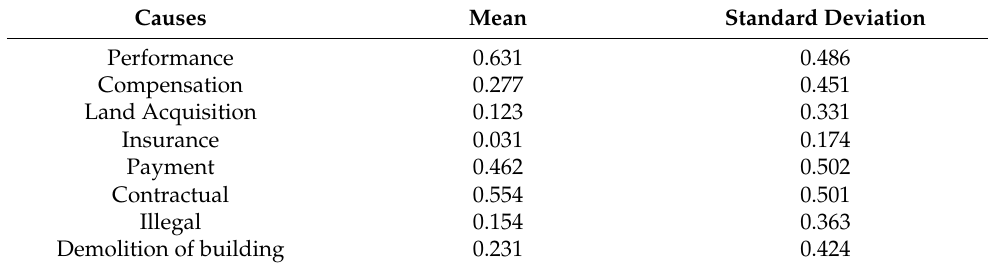
Table 4. Descriptive Statistics of Cause of